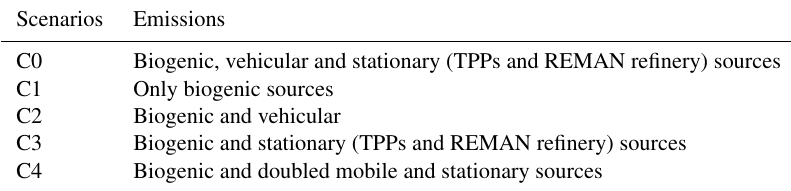
Table 4. Summary of simulation scenarios.